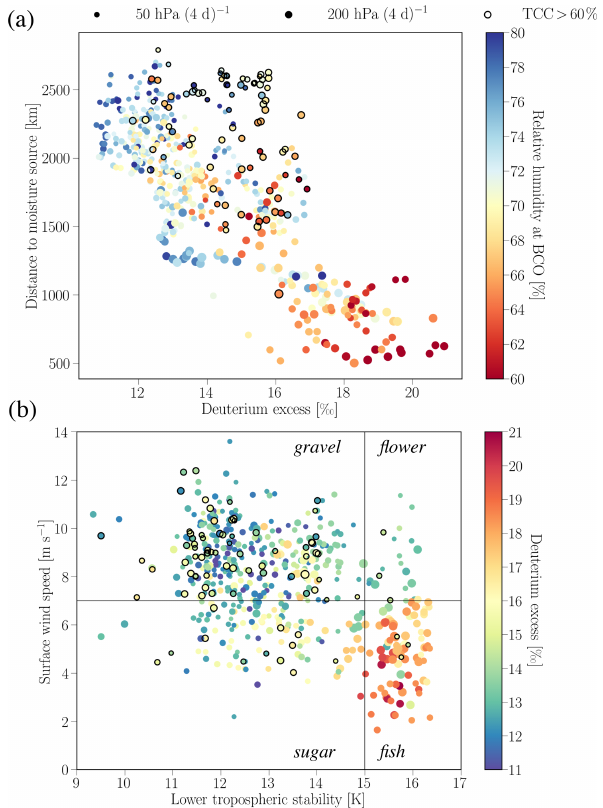
Figure 16. Summary scatter plots showing in (a) the relation be- tween the d with the moisture source distance (Pearson correla- tion − 0 . 73) and in (b) the relation between the d and the variables that allow for the discrimination between different cloud patterns (the surface wind speed and the lower-tropospheric stability; see Bony et al., 2020b). The Pearson correlation between the d and the lower-tropospheric stability r(d , LTS ) = 0 . 52 and between the d and the surface wind speed r(d , U) = − 0 . 57. In both (a) and (b) , the size of the dots is scaled with the subsidence rate within 4d (cid:49)p 4d along back trajectories starting from Barbados. The data points with total cloud cover of more than 60% along the trajec- tories are circled in